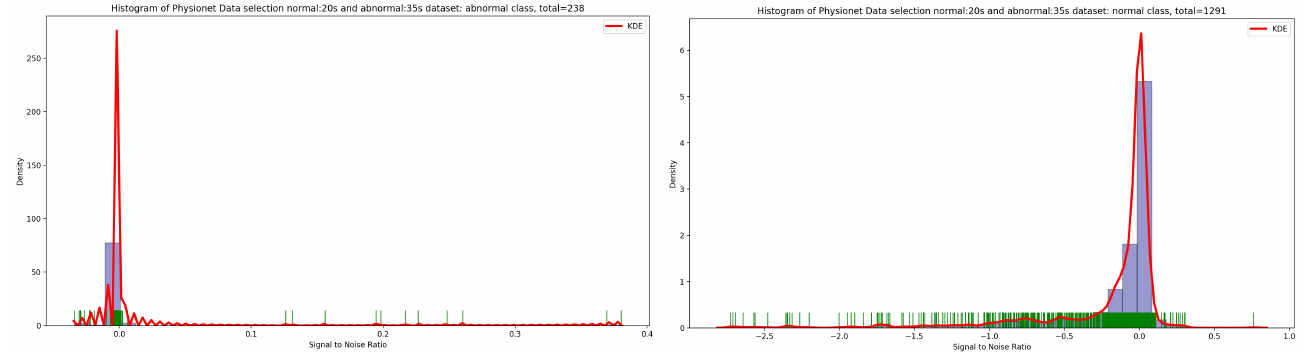
Figure 5. An overview of the PCG sample distribution in function of duration after selecting samples: 35 s from abnormal class and 20 s from normal class.